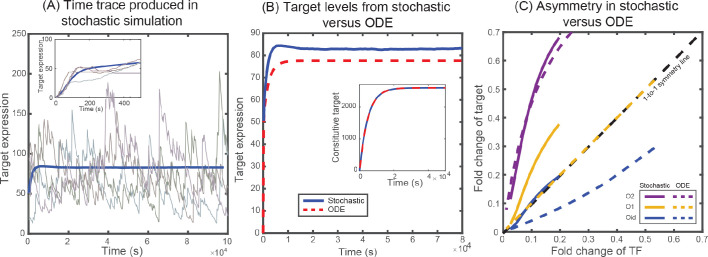
Solutions from stochastic simulation and from deterministic ODEs.(A) Representative time traces of target expression in individual cells (grey shades) from stochastic simulations. Blue solid line represents the mean behavior averaged over 5 × 104 iterations. Inset shows the transient behavior. (B) Plot showing the average target expression in the negative SIM motif from stochastic simulations (solid line) and from solving deterministic ODEs (dashed line). Inset shows that when regulation is removed the average levels are identical for stochastic and deterministic models. (C) Plot showing the asymmetry between TF and target expression from using either stochastic simulation (solid lines) or solving deterministic ODEs (dashed lines). The TF is always regulated by O1 binding site, whereas the target is regulated by O1 (yellow), O2 (purple) or Oid (blue) binding sites. The black dashed line represents line of no asymmetry.